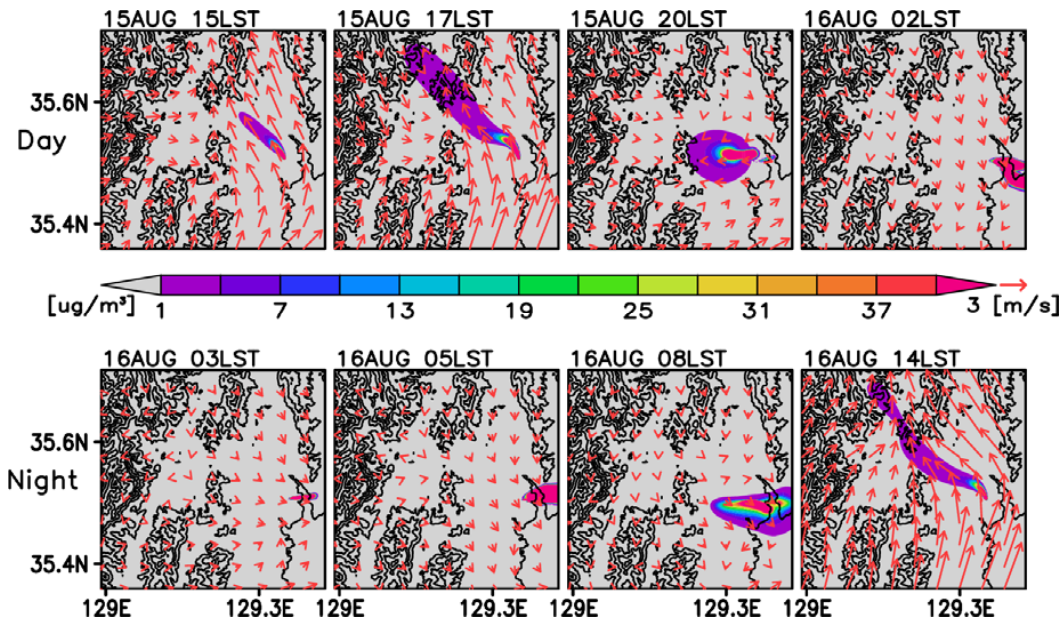
Figure 3. Time evolution of chemical dispersion from the daytime emission ‐ started (upper) and the nighttime emission ‐ started (lower) cases for the selected dates of 14:00 LST 15 August and 02:00 LST 16 August 2013, respectively. Shaded is the benzene concentration at the surface after 1, 3, 6, and 12 h after the start of emission. Also shown is the wind (arrow in red) and the topography (contour in black).